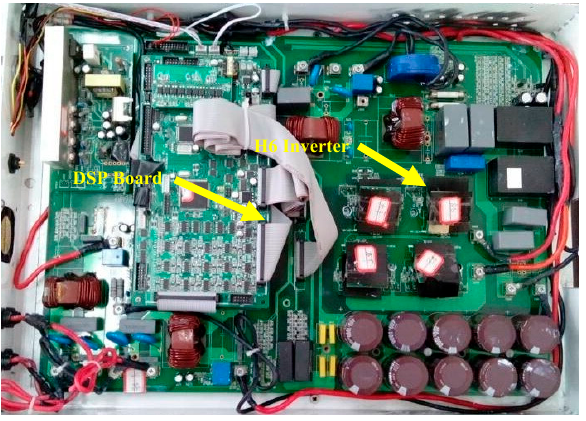
Figure 18. The prototype of H6 grid-tied inverter. Table 3. Parameters of the experimental